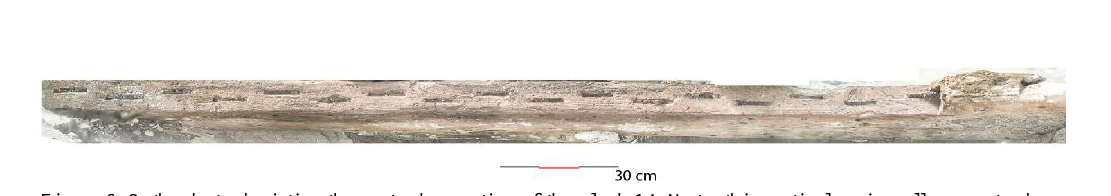
Figure 6. Orthophoto depicting the east-edge section of the plank 14. Note: this particular view allows us to show the mortises of the plank (photogrammetry: Bruno Derenne/Georges